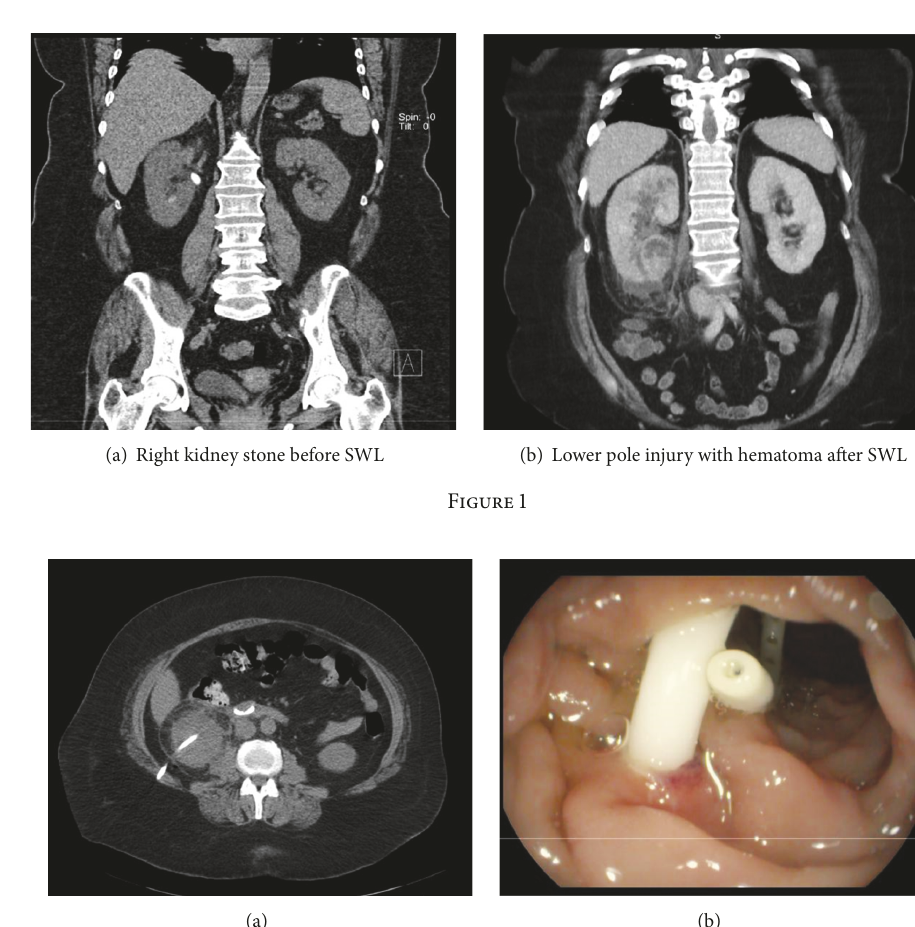
Figure 2: (a) CT. Percutaneous drain in the second part of the duodenum. (b). Pigtail of the percutaneous drain in the second part of the